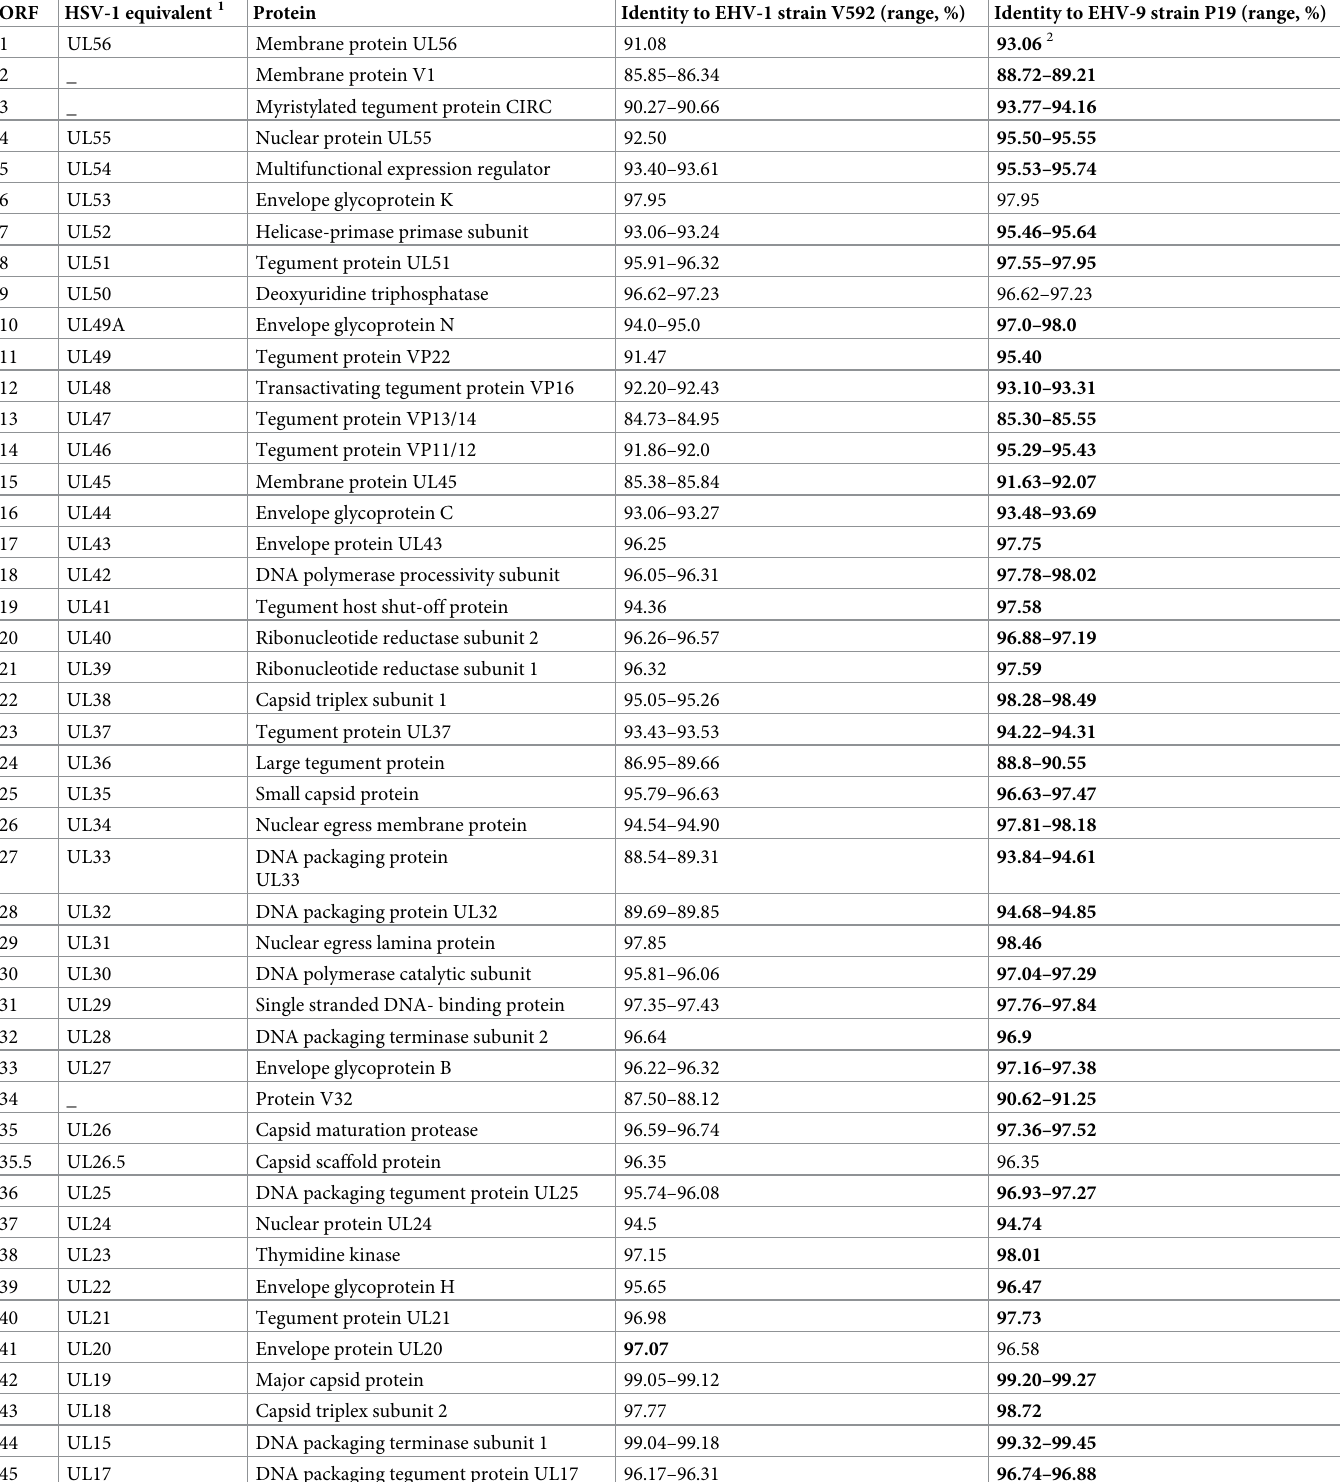
Table 3. Amino acid sequence identity of genes of the Irish EHV-8 strains to their homologues in EHV-1 and